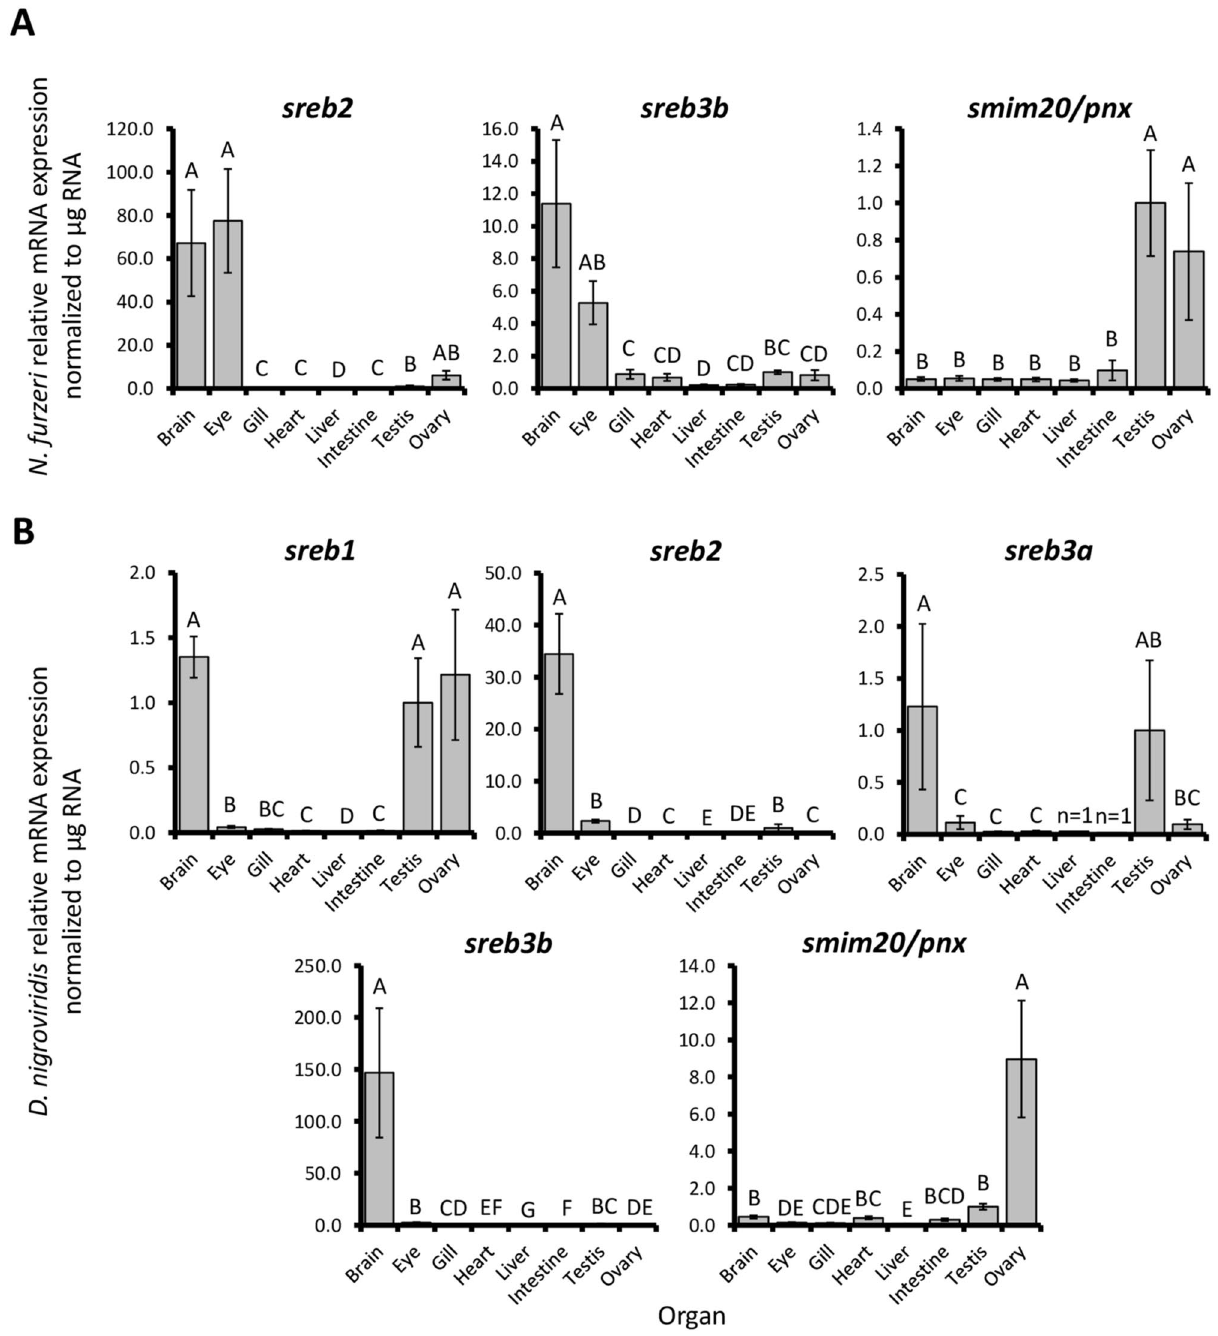
Figure 9. Relative mRNA expression patterns for sreb genes and smim20/pnx in selected organs of ( A ) African turquoise killifish ( Nothobranchius furzeri ), and ( B ) green-spotted puffer ( Dichotomyctere nigroviridis ). Relative expression levels were normalized to RNA input quantity (0.6–2.5 μg). D. nigroviridis sreb3a was not detected in most liver and intestine samples (n = 1 each). Each bar represents the mean ± standard error and different letters indicate significant differences ( p <